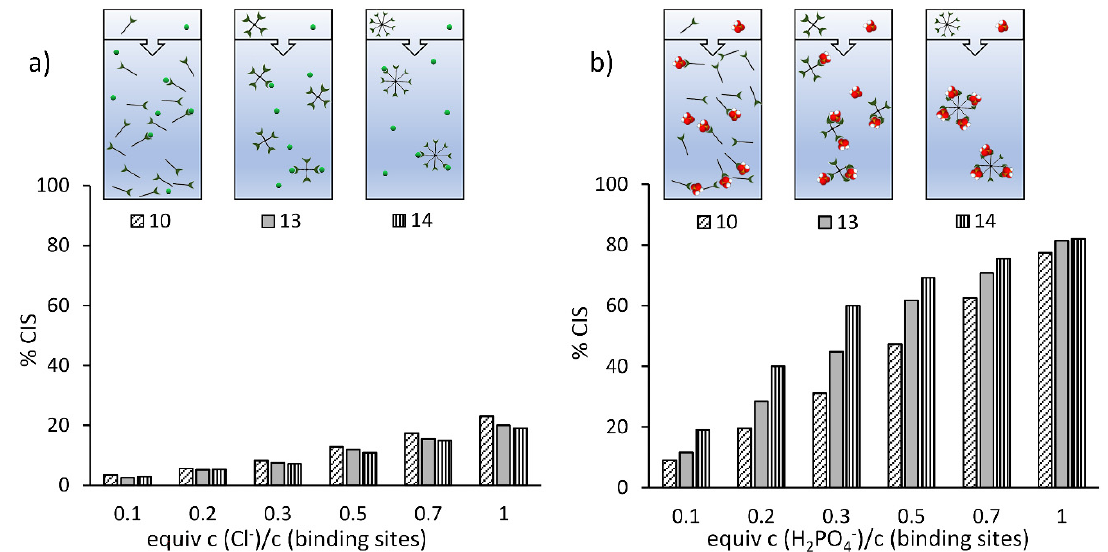
Figure 1. Comparison of complexation progress in DMSO solutions of receptors 10 , 13 and 14 with respect to concentration of binding sites with ( a ) TBA + Cl − , shift of N H (H at N15 in the crystal structure, Figure S64), ( b ) TBA + H 2 PO 4 − , shift of Ar H (H at C3/5 in the crystal structure, Figure S64).